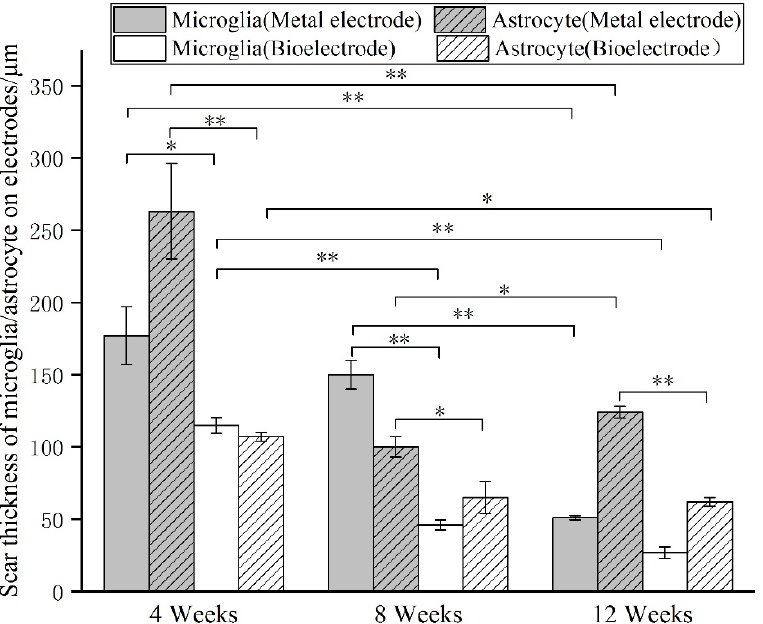
Figure 9. Scar thickness of microglia/astrocytes on metal/bio electrodes at different times. (* p < 0.05, ** p < 0.01).